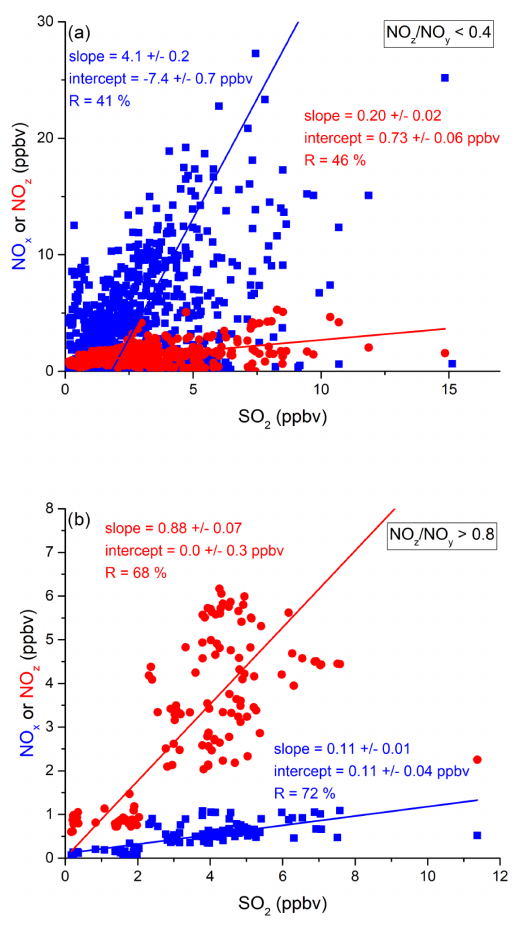
Figure 13. Correlation between SO 2 and NO x or NO z for (a) fresh and (b) aged NO x emissions in the Arabian Gulf